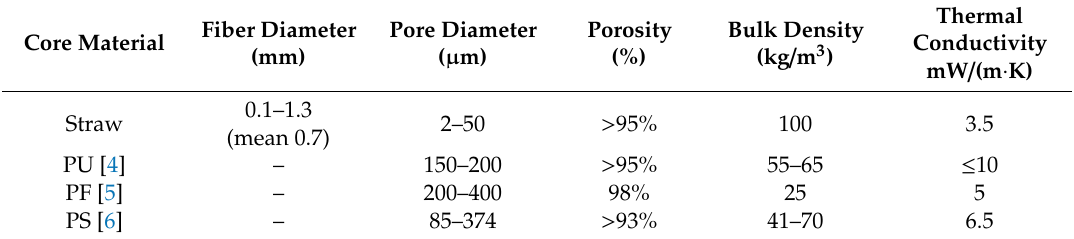
Table 1. Comparison of VIPs prepared with different core material.